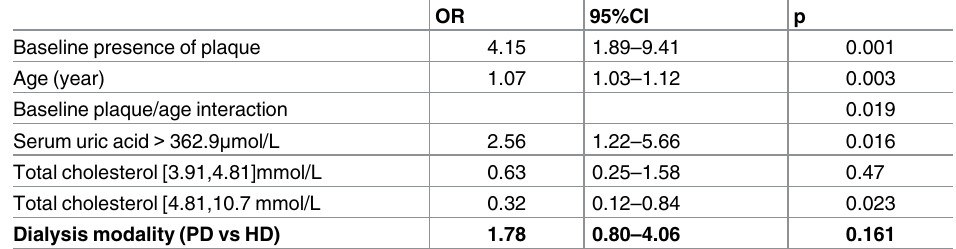
Table 4. Multivariate logistic model for progression in plaques.